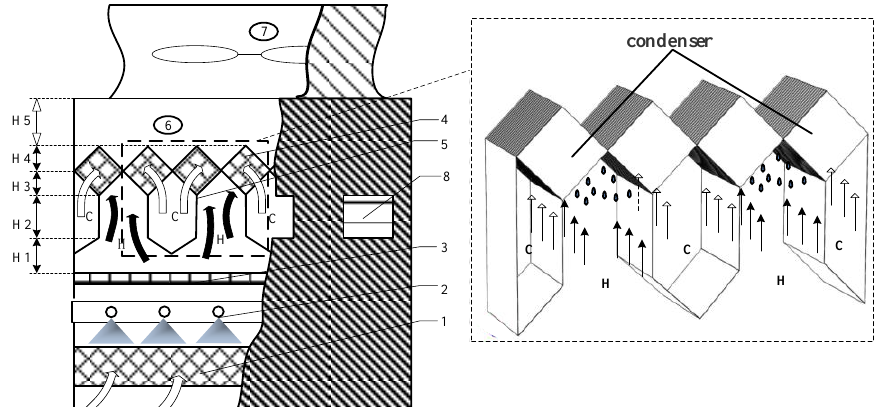
Figure 4. Vapor-condensing plume abatement device for the free space cooling towers (FSCTs). 1, Fill; 2, Sprinkler; 3, Water collector; 4, Condenser; 5, Baffle; 6, Transition chamber; 7, Fan; 8, Louvered inlet.